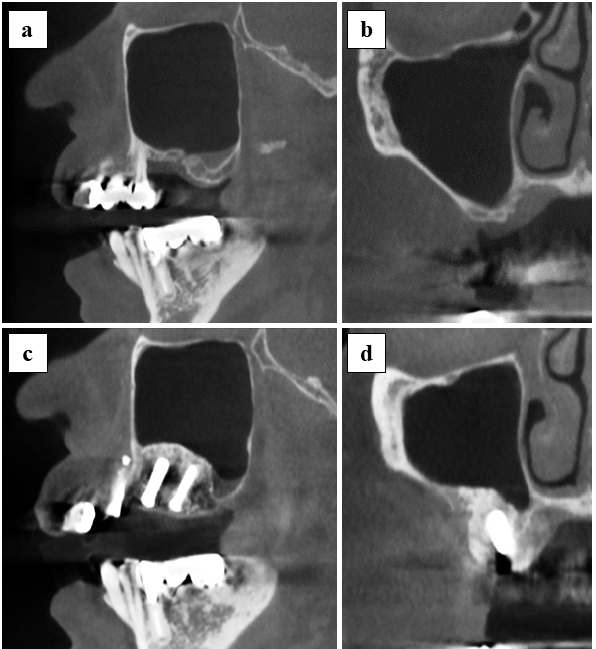
Figure 4. Quantitative measurement of vertical bone height at the transplanted site is shown. *; p < 0.05, statistically sig- nificant difference.